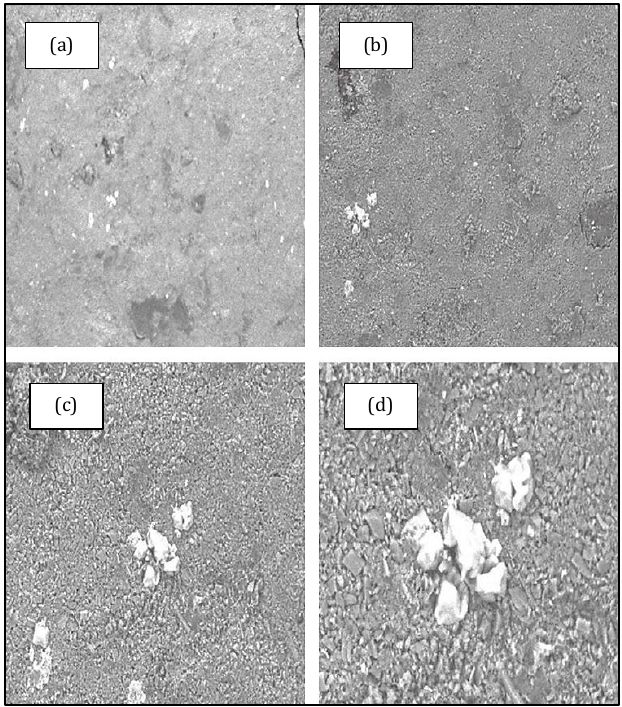
Figure 2: (a-d) Magnesium oxide nanoparticles with